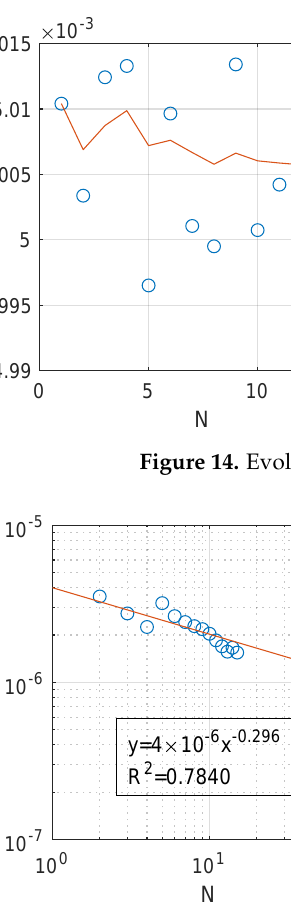
Figure 13. 3D scatter plot in the optimization variable space, each circle is a PSO optimization, the colour represents the decimal logarithm of best f ( x ). The small dark blue cluster is in close proximity of the known target optimization value of x and contains 15 Monte-Carlo realizations.